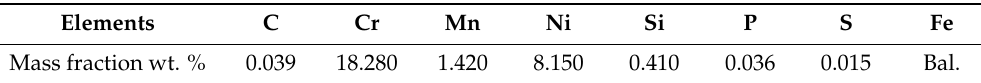
Table 1. Material composition.